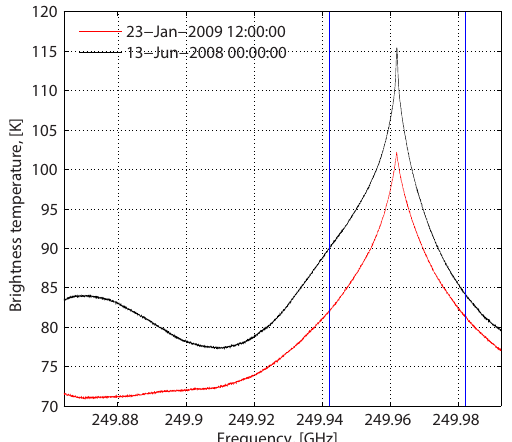
Figure 2. Noon summer (red) and midnight winter (black) cali- brated atmospheric spectra. The blue vertical lines indicate the fre- quency range of the spectra used in the O 3